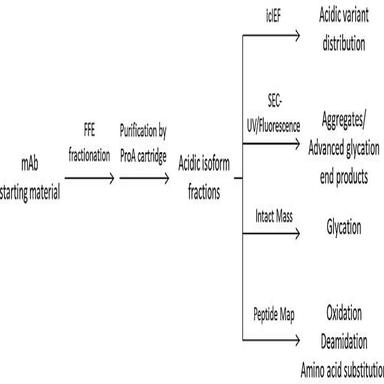
Workflow of acidic variant fractionation and characterization.